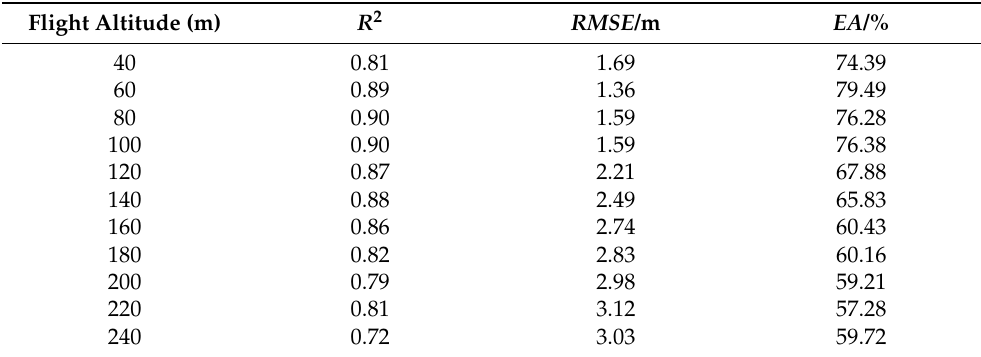
Table 9. The influence of different UAV flight altitudes on the tree-height estimation for C. equisetifolia between UAV-derived images and field measurements.